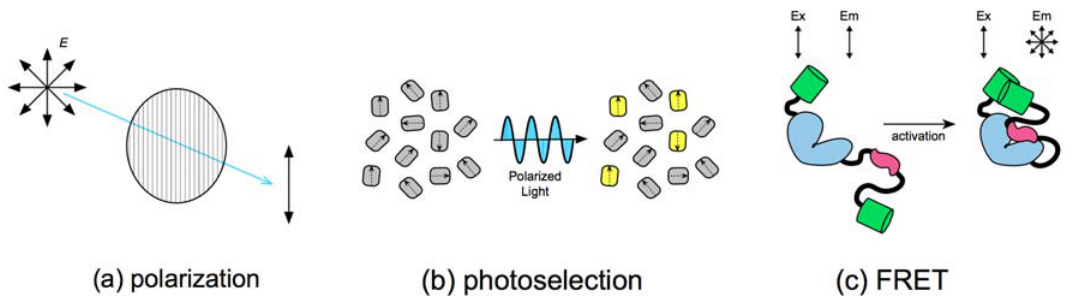
Figure 1. ( a ) Plate polarizers are used to constrain the illumination light to a single orientation; ( b ) polarized light can only stimulate absorption in fluorophores with compatible molecular geometries; ( c ) fluorescent proteins illuminated with polarized light will emit light in the same polarization plane. Photons emitted from Förster resonance energy transfer (FRET) excited fluorophores come from alternate orientations, depolarizing fluorescence as a function of FRET efficiency.